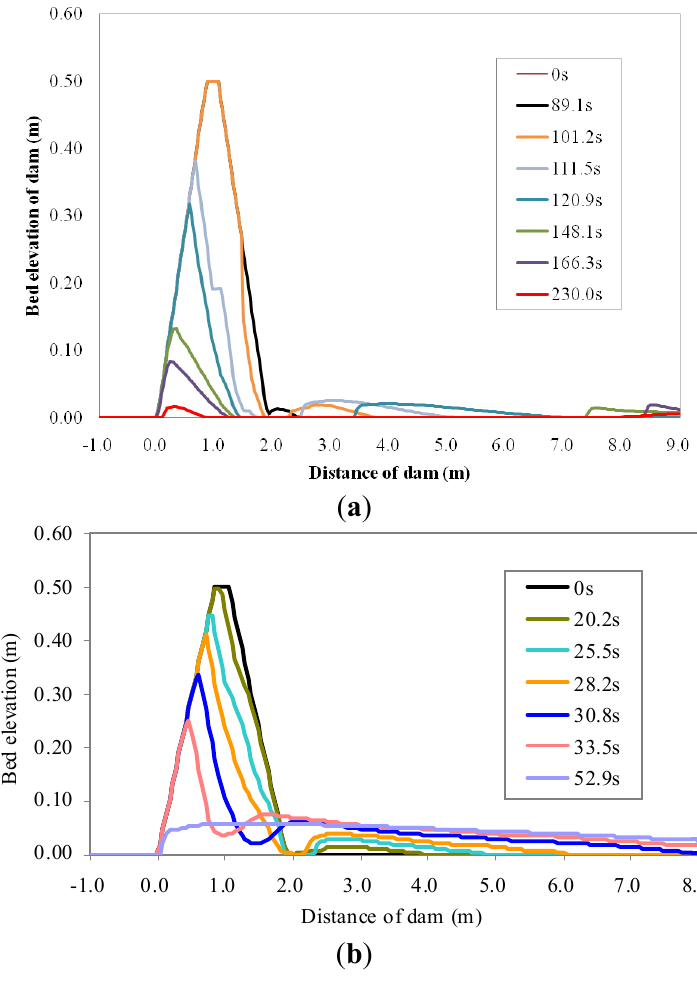
Figure 13. Comparison of bed changes along the flow direction at different times with and without waves. Numerical results of bed elevation along the central flow direction are plotted in the colored lines: ( a ) bed elevation changing with time in the case with no wave; ( b ) bed elevation changing with time considering overtopping